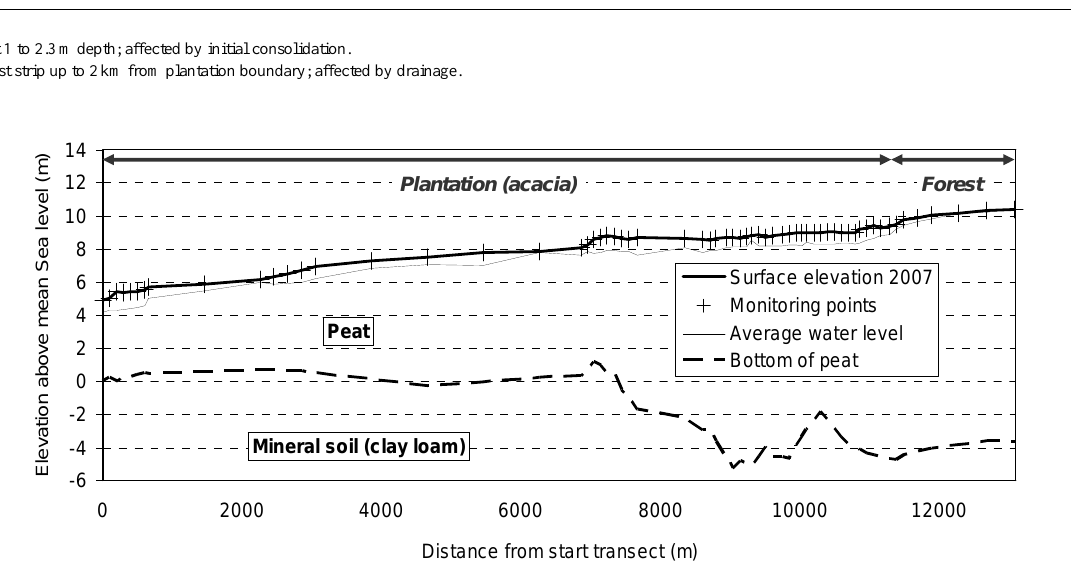
Fig. 1. Cross section along typical study transect in Sumatra, 6 years after drainage, showing variation in peat depth, average water level, land use and monitoring location density.